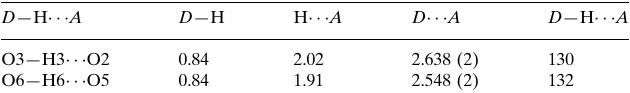
Hydrogen-bond geometry (A˚ , (cid:1)